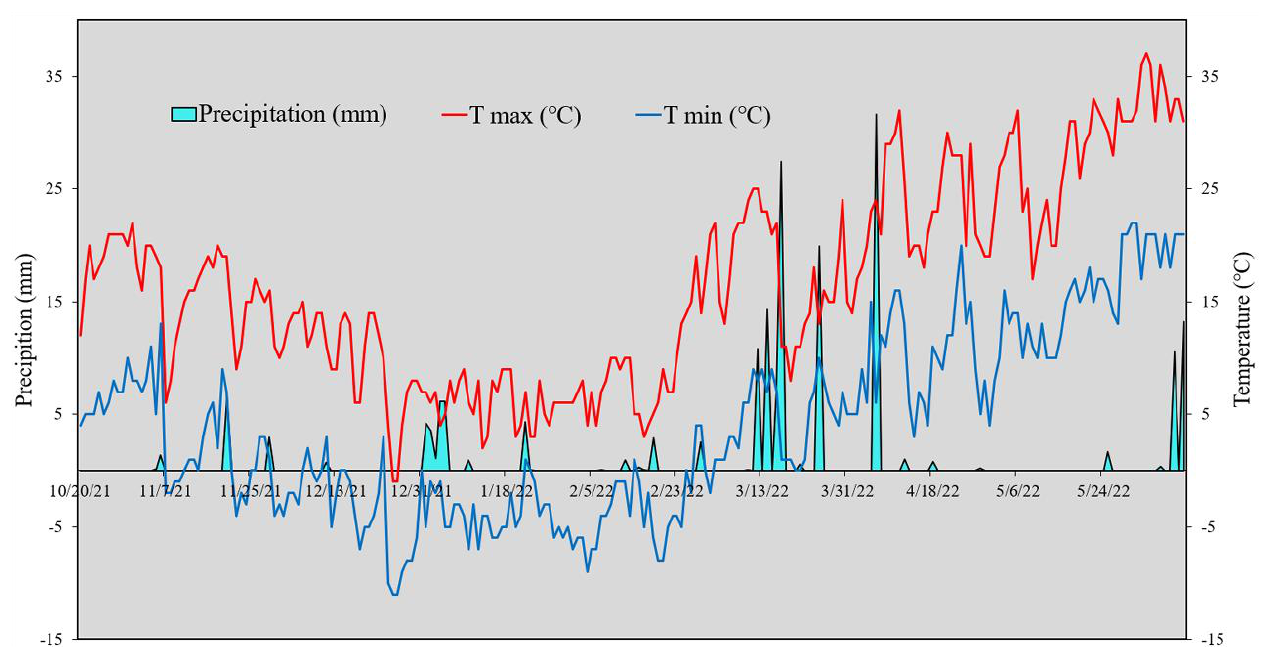
Figure 2. Daily precipitation, and maximum and minimum temperature for study area during 2021/2022 growing season.